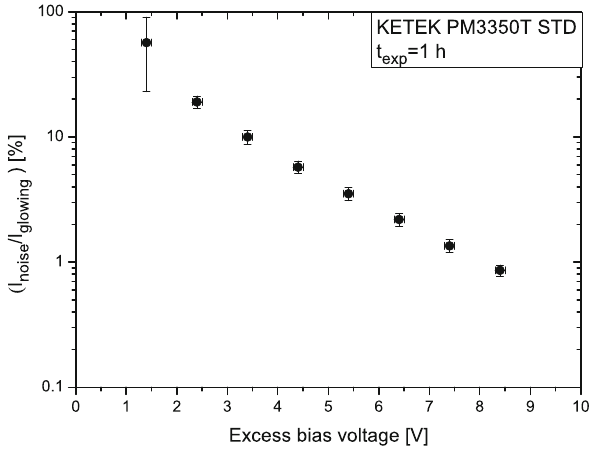
Fig. 8 Contribution of the CCD noise I noise to I glo w